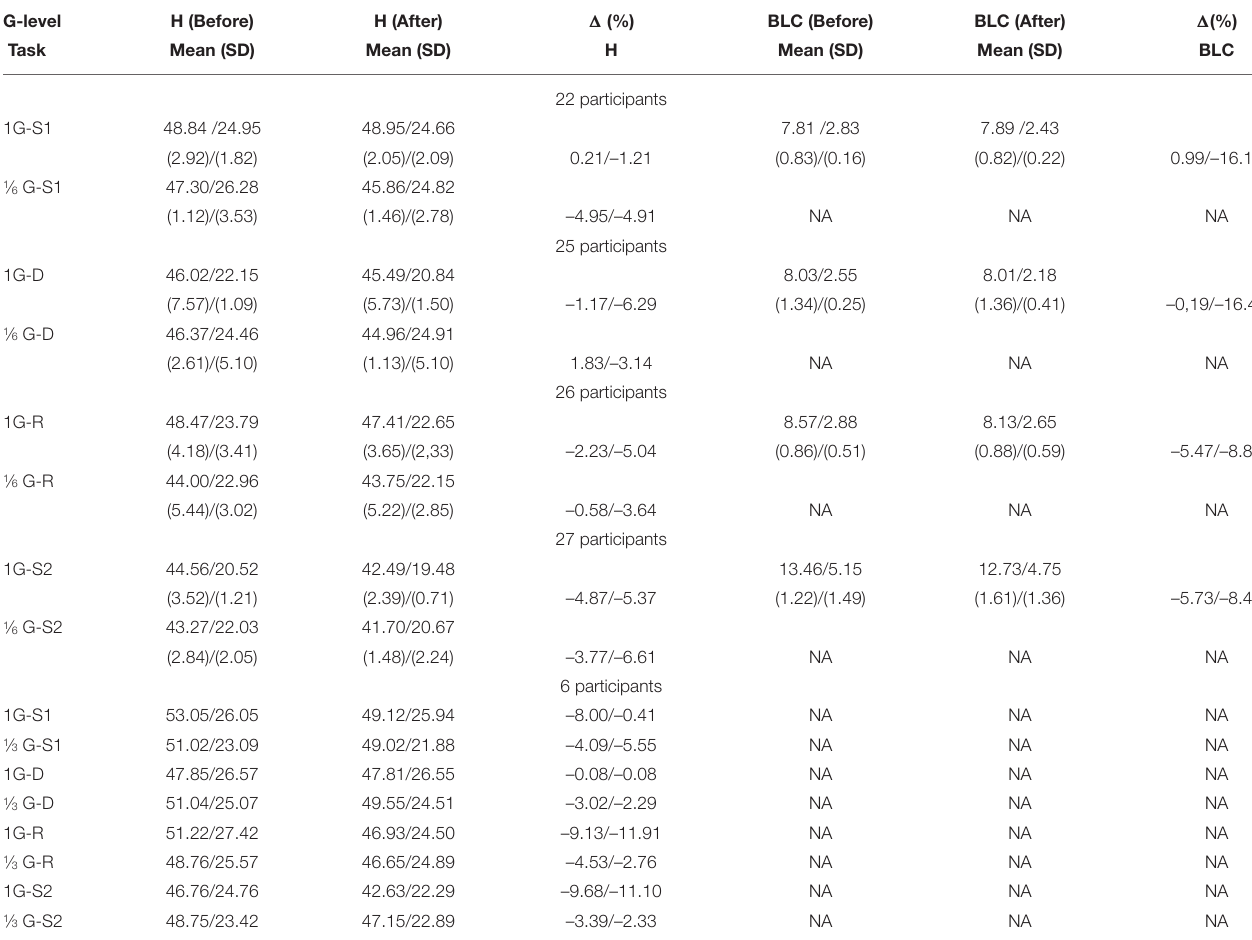
TABLE 3 | Before and after variation hand (H) and back-leg-chest (BLC) strength values, including % of variation.